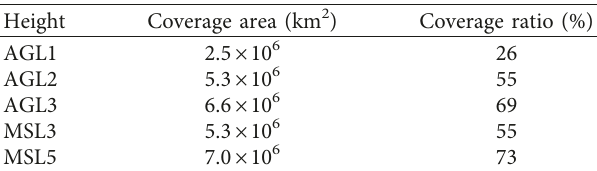
Figure 7: Effective coverage map of CINRAD network at heights of (a) 3km and (b) 5km above MSL over China. The legend refers to the number of overlapping radars covering a given point in space and the subgraph at the bottom right corner of each panel represents the South China Table 2: Coverage index of China Next Generation Weather Radars.